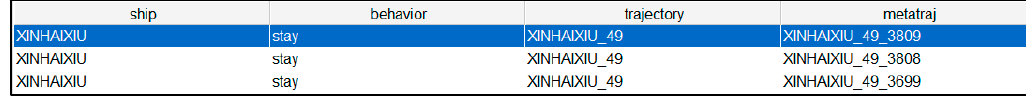
Figure 13. The SPARQL query results of ship behavior.